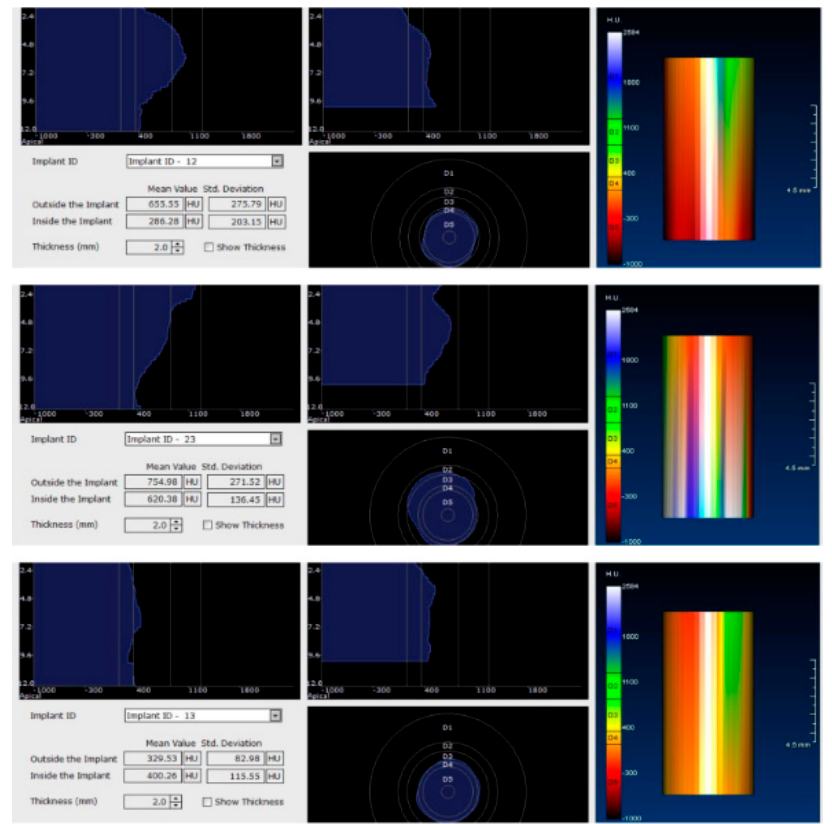
Figure 13. Bone density around dental implants at 60 following surgery with MED™ electromagnetic healing caps.